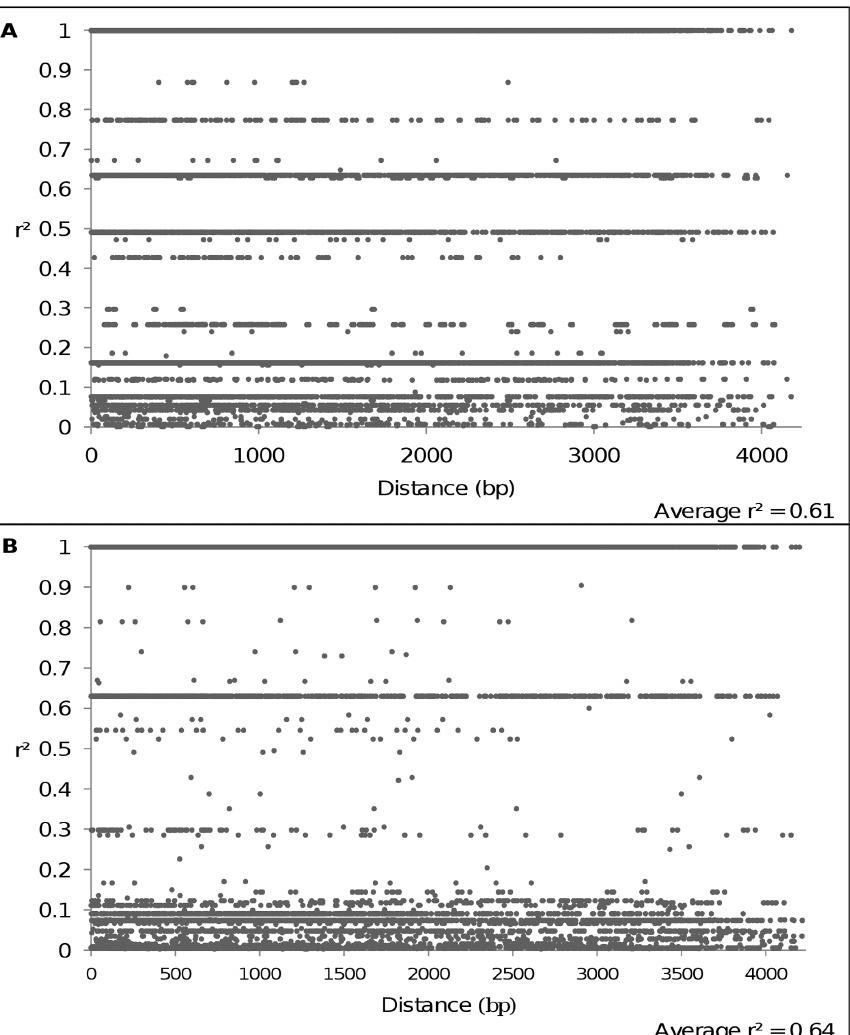
Figure 3. Linkage disequilibrium along CRTISO gene for the (A) Western and (B) Eastern genetic groups. LD level was measured by squared correlations of allele frequencies ( r 2 ) against physical distance between pairs of SNPs.